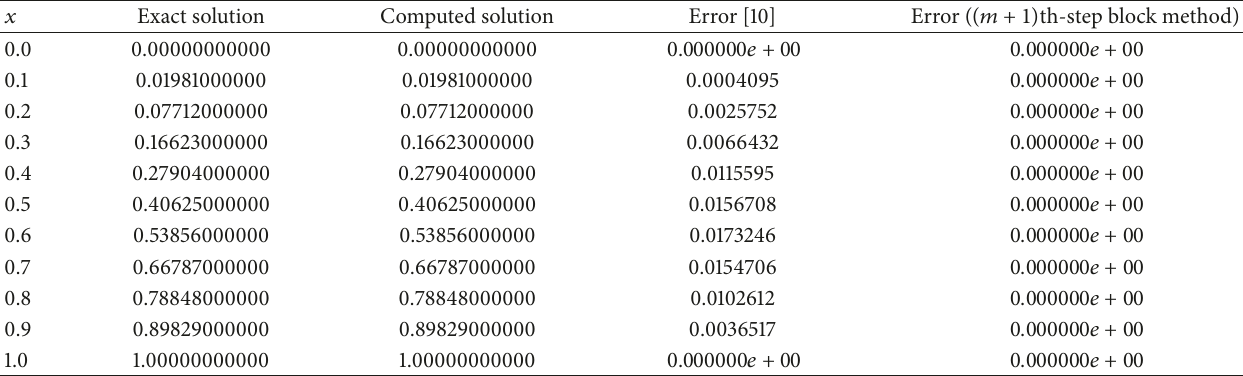
Table 2: Comparison of the exact and computed solution of Example 8.